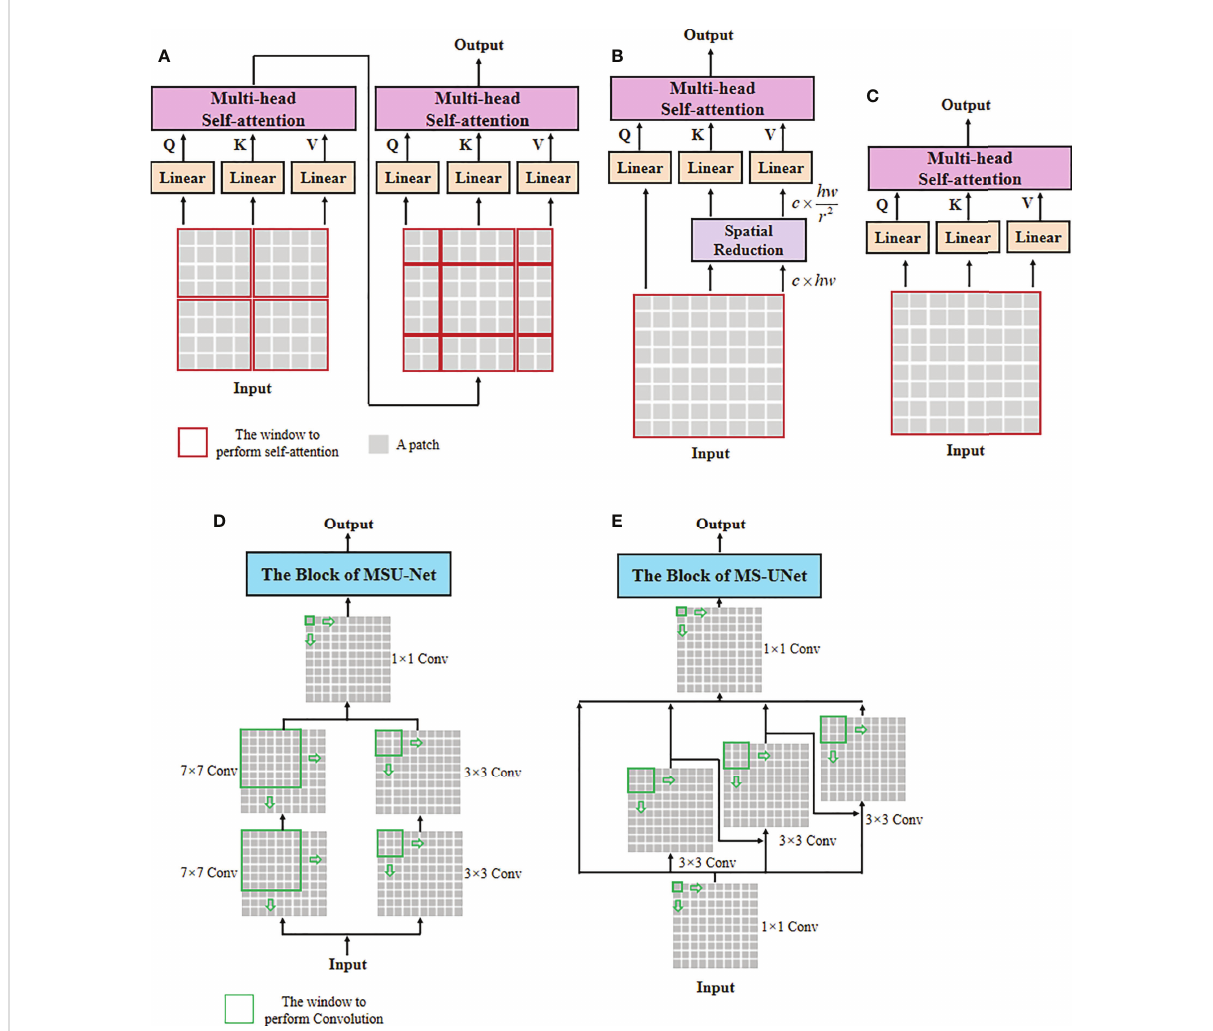
FIGURE 4 The architectures of self-attention and multi-scale convolution. (A) Window-based multi-head self-attention (W-MSA), (B) spatial reduction attention (SRA), (C) multi-head self-attention (MSA), (D) multi-scale convolution of MSU-Net, and (E) multi-scale convolution of